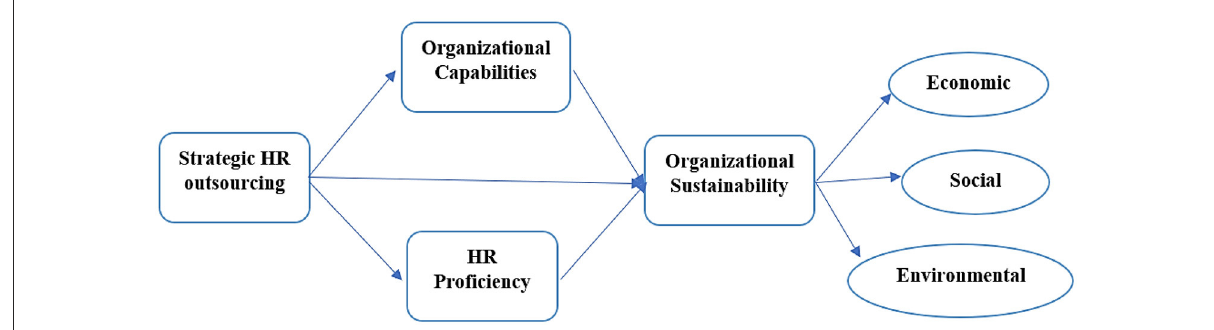
FIGURE1 Theoretical